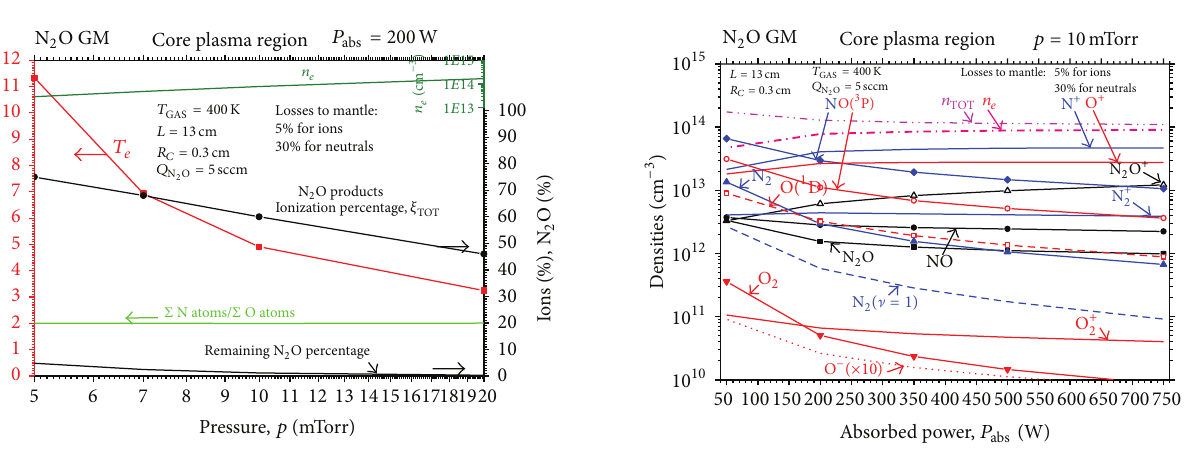
Figure 8: Variation of the densities of species in the “core” region of a N 2 O fed HPT as a function of absorbed power for